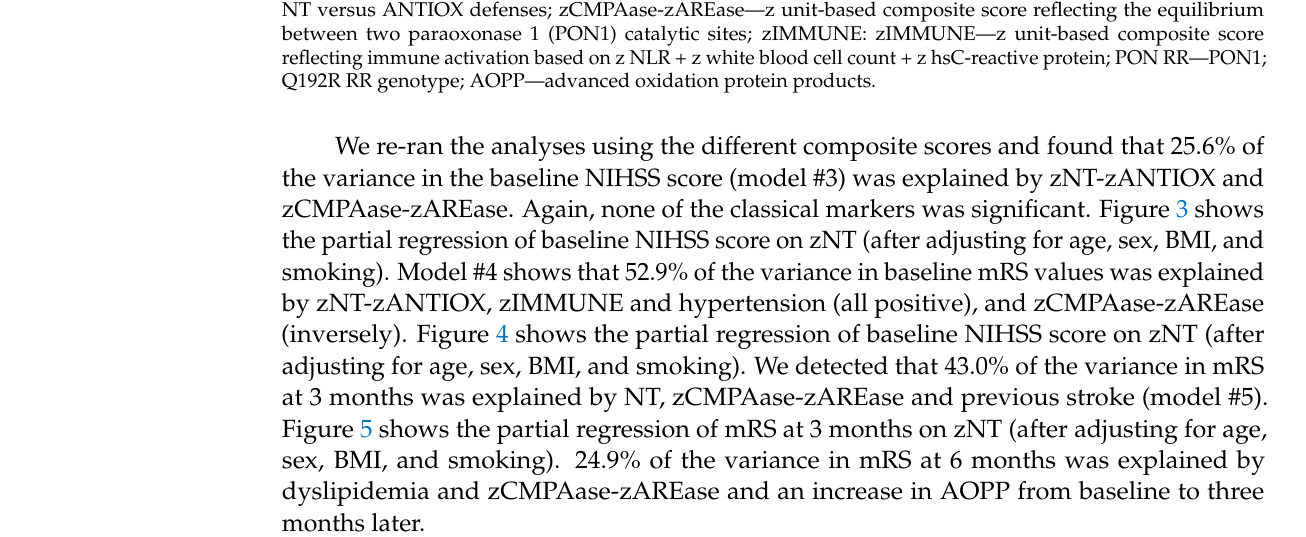
Figure 4. Partial regression of the baseline modified Rankin score (mRS) on an index of antioxidant defences (after adjusting for age, sex, BMI, and smoking).